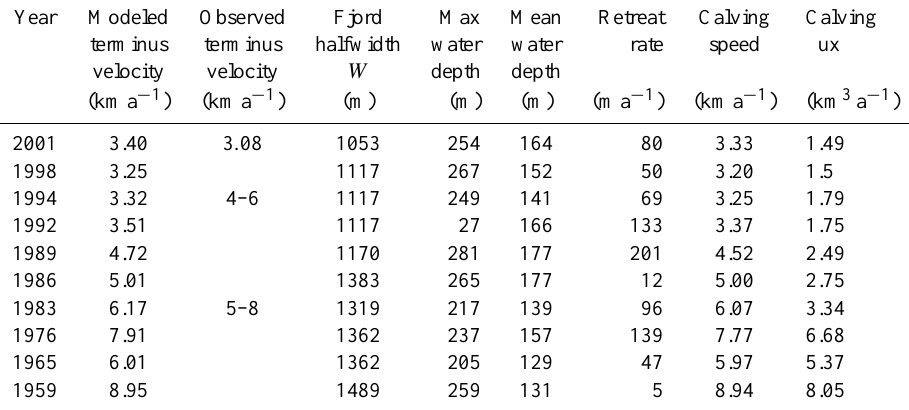
Table 3. Modeled velocities at the terminus using sliding, lateral drag and bathymetry developed in Benn et al. (2007) and Eqs. (8–12), for years with known terminus positions and bathymetric data, and observed terminus velocities for years with available data (Kondo and Yamada, 1988; Warren et al., 1995; Rignot et al., 1996; E. Rignot, personal communication, 2003). Calving speeds calculated according to definition in Eq. (8). Calving fluxes Q calv calculated as product of calving speed and ice front area A term